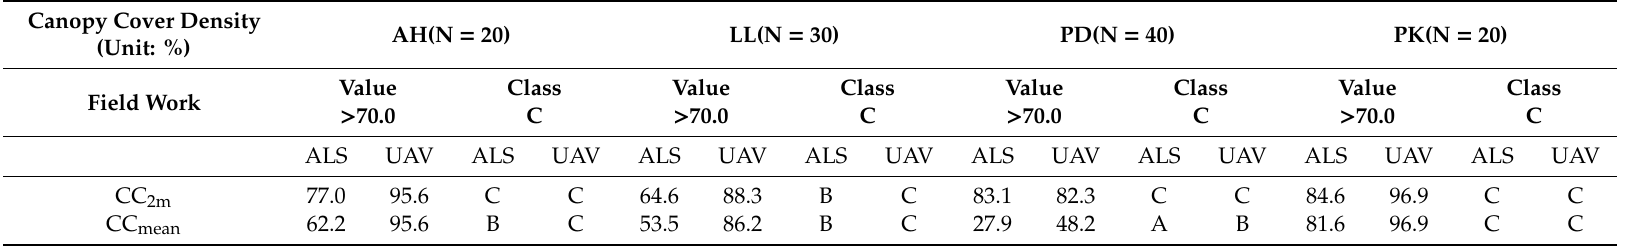
Figure 4. Scatter plot for a comparing the measured tree height using H max and H 95 from UAV and ALS with Fieldwork result. a ) Hmax-UAV; b ) Hmax-ALS; c ) H95 -UAV; d ) H95-ALS Table 9. Comparison of the canopy cover density CC 2m and CC mean calculated by fieldwork, UAV, and ALS. Canopy Cover